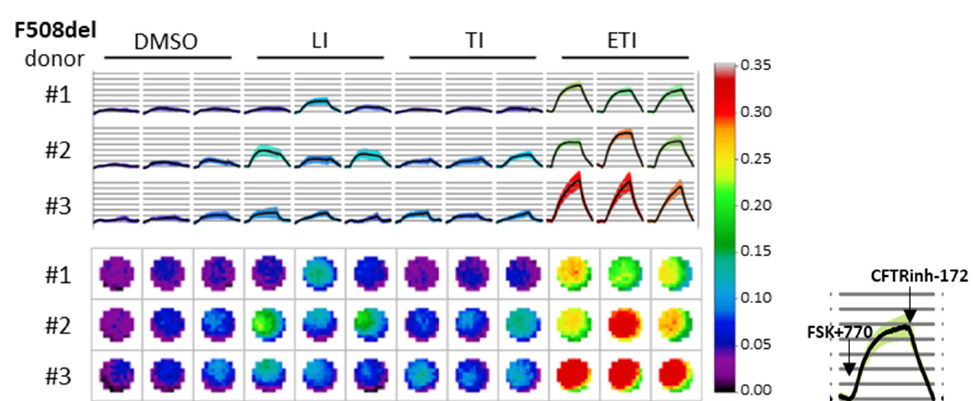
Figure 1. FMP plate reader studies of responses to forskolin plus ivacaftor (I) on nasal cultures from 3 donors possessing F508del on both alleles: The traces on top show reproducible responses to forskolin plus ivacaftor after long-term treatment with DMSO, L = lumacaftor, T = tezacaftor, or ET = elexacaftor plus tezacaftor. The insert to the far right shows the point in the trace when the stimulatory intervention (Fsk+I) was added and the point at which the inhibitory intervention (CFTRInh-172) was added. The total time represented by the trace = 35 min. The coloured regions in the traces are +/ − 1 SD of the mean at each time point. The mean is indicated as the black tracing. Traces are colour-coded according to the magnitude of response. The dots in the bottom panel represent a different visualization, with each dot showing a well scan of the FMP response across each culture surface, coloured according to magnitude. The colour scale bar indicates the percentage change in fl uorescence measured using the FMP method.